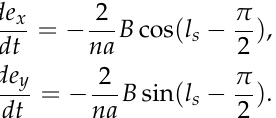
) = ( 0,0 ) in the , e y 0 0